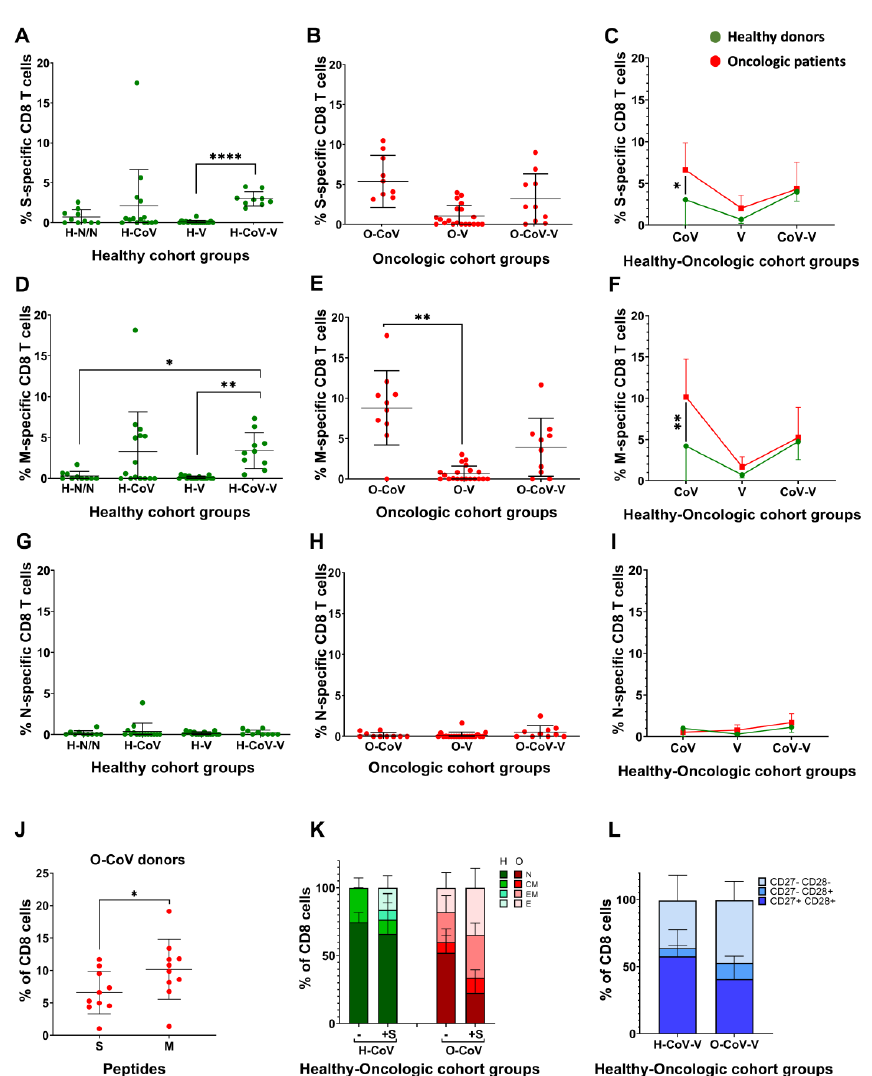
Figure 3. CD8 T-cell responses to S, M and N peptides of SARS-CoV-2 proteins. Paired backgrounds from technical controls were removed from the data. ( A – C ) Percentage of S-specific CD8 T-cells in PBMCs stimulated with S-peptides in healthy donors and oncologic patients. ( D – F ) Percentage of S-specific CD8 T-cells in PBMCs stimulated with M-peptides in healthy donors and oncologic patients. ( G – I ) Percentage of S-specific CD8 T-cells in PBMCs stimulated with N-peptides in healthy donors and oncologic patients. ( A , B , D , E , G , H ) Significance was tested with Kruskal–Wallis tests, followed by Dunn’s test. ( J ) Percentage of activated CD8 T-cells after stimulation with S- or M-specific peptides in O-CoV donors. ( C , F , I , J ) U of Mann-Whitney was used to test for significance. ( K ) Relative percentages of CD8 T-cell differentiation phenotypes in the indicated groups of healthy donors and oncologic patients. Means and error bars (standard deviations) are shown. N, CM, EM and E, indicate naïve- stem cell (CD62L+ CD45RA+), central memory (CD62L+ CD45RA neg ), effector memory (CD62L neg CD45RA neg ) and effector (CD62L neg CD45RA+) phenotypes. Relevant statistical comparisons are detailed in Figure S8. ( L ) Relative percentages of CD8 T-cell differentiation phenotypes in the indicated groups of healthy donors and oncologic patients according to CD27 neg CD28 expression profiles. CD27 + CD28 + , CD27 neg CD28+ and CD27 + CD28 + indicate poorly differentiated, intermediate differentiated and highly differentiated T-cell phenotypes. H-N/N—non-vaccinated, non-COVID-19 donors; H-CoV—healthy donors with previous COVID-19 infection; H-V—vaccinated healthy donor; H-CoV-V—vaccinated healthy donor with previous COVID-19; O-CoV—oncologic patient with previous COVID-19; O-V—vaccinated oncologic patients; O-CoV-V—vaccinated oncologic patients with previous COVID-19; *, ** and **** indicate significant ( p < 0.05), very significant ( p < 0.01) and very highly significant ( p < 0.0001) differences,